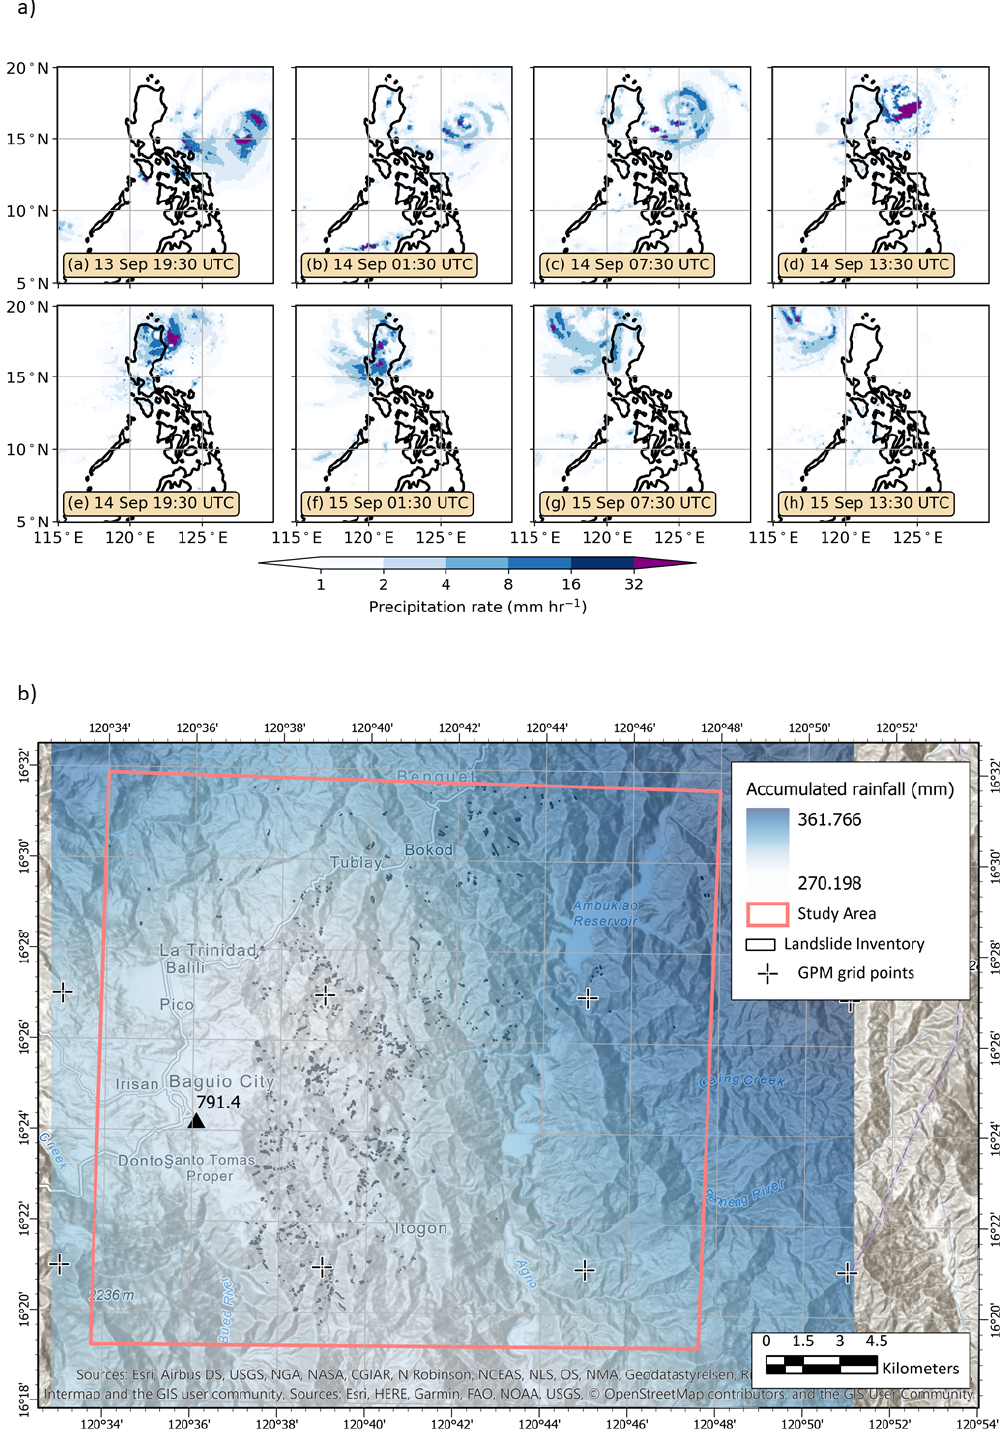
Figure 2. (a) GPM IMERG data showing the evolution of Typhoon Mangkhut over the Philippines between 13 and 15 September 2018; (b) accumulated rainfall during Typhoon Mangkhut (13 September 2018 at 19:30 to 15 September 2018 at 15:30UTC) within the study area and its surroundings, according GPM IMERG data (map) and rain gauge records in Baguio city (black triangle). © OpenStreetMap contributors 2021. Distributed under a Creative Commons BY-SA